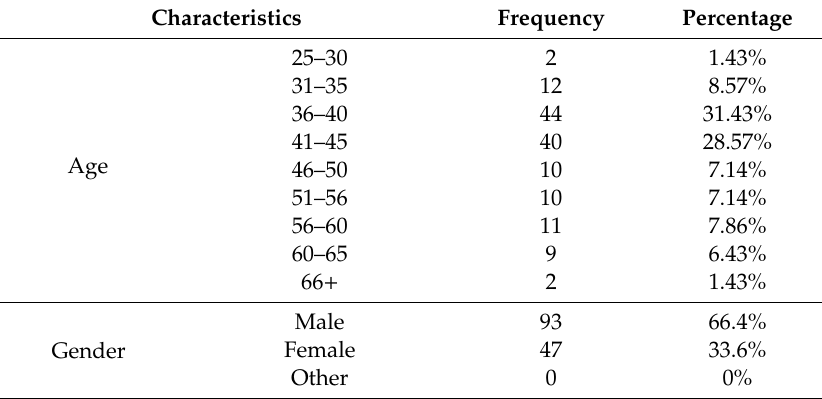
Table 2. Summary of respondent